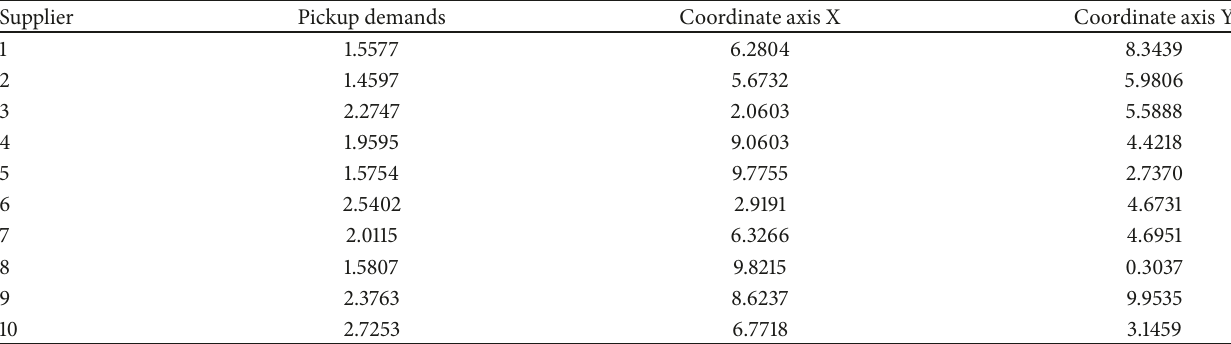
Table 1: Pickup demands (tons) and coordinate positions (km) of instances 10-2-1.